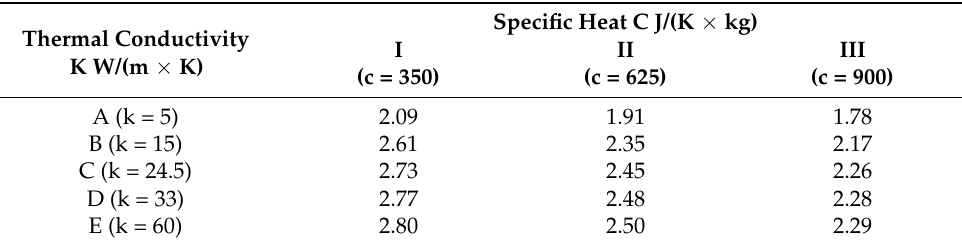
Table 7. Summary of the influence of the thermal conductivity and specific heat coefficient on the maximum values of relative deformations of the contact strip.